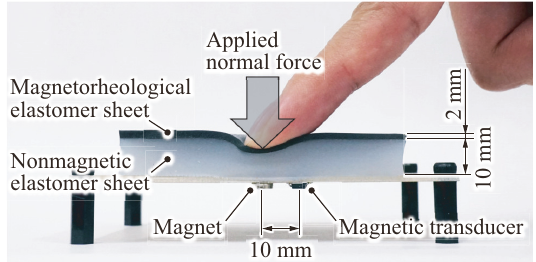
Figure 1. Basic structure of the proposed flexible tactile sensor, which can detect an applied normal force and vertical deformation (modified from